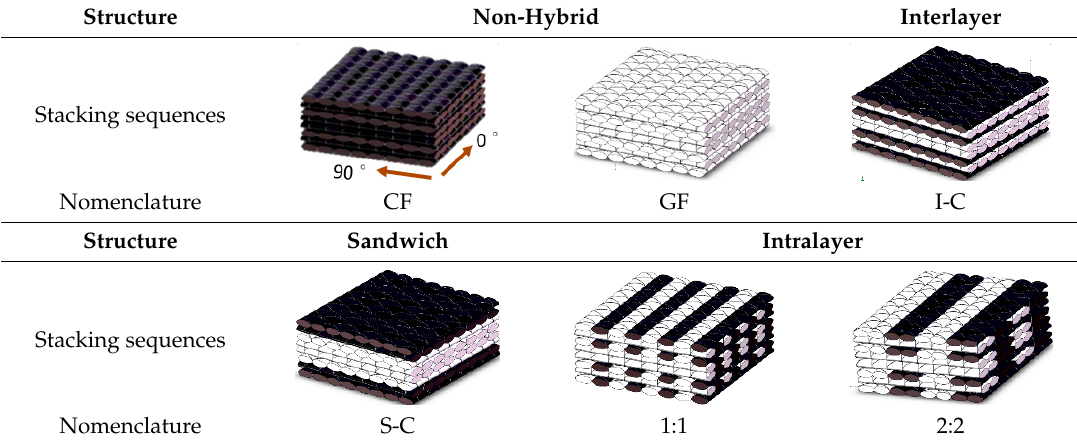
Table 2. Stacking configurations of hybrid structures.